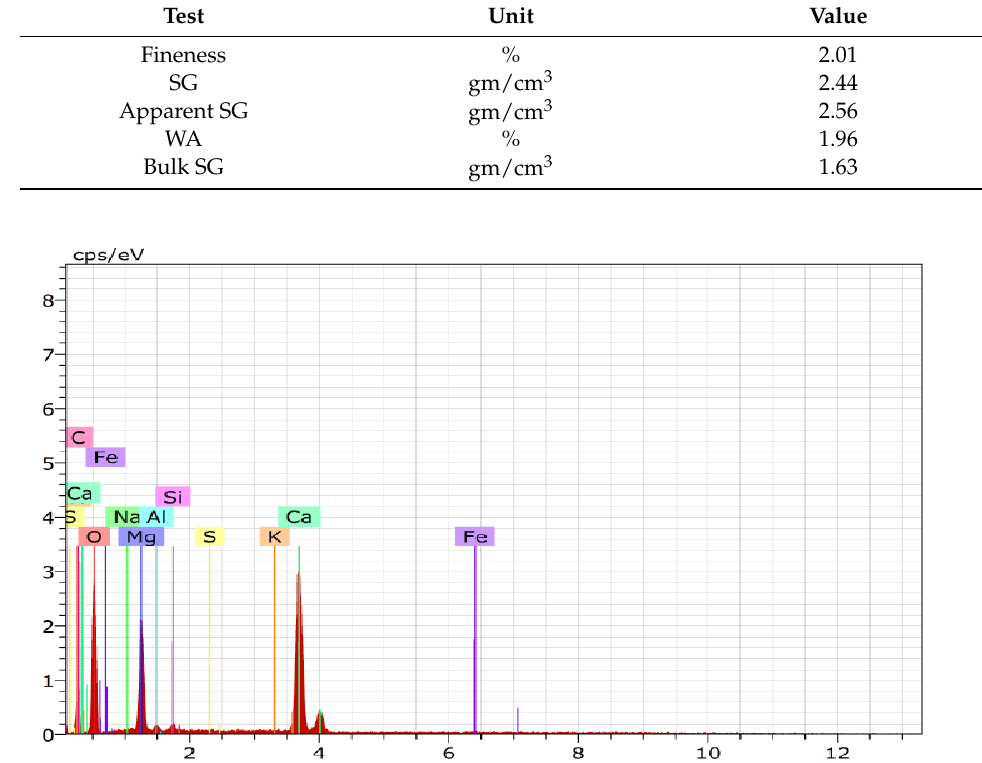
Figure 2. Chemical Analysis of Marble Powder. Table 3. Mechanical Characteristics of MP.